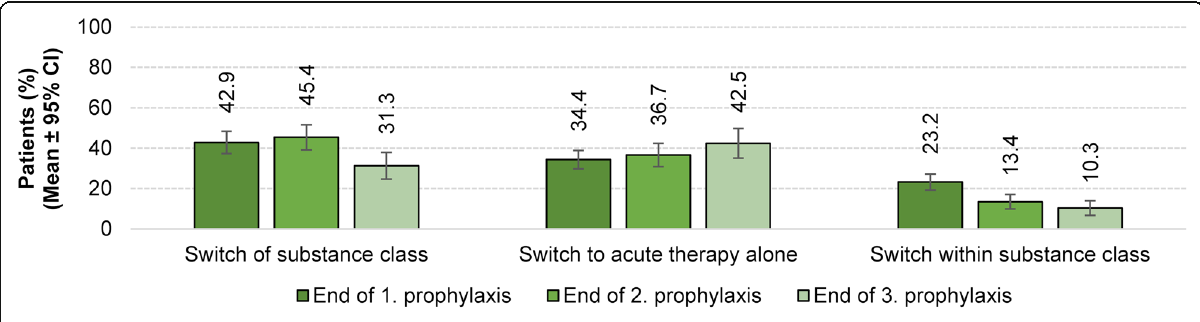
Fig. 6 Therapeutic options after discontinuation of prophylactic migraine